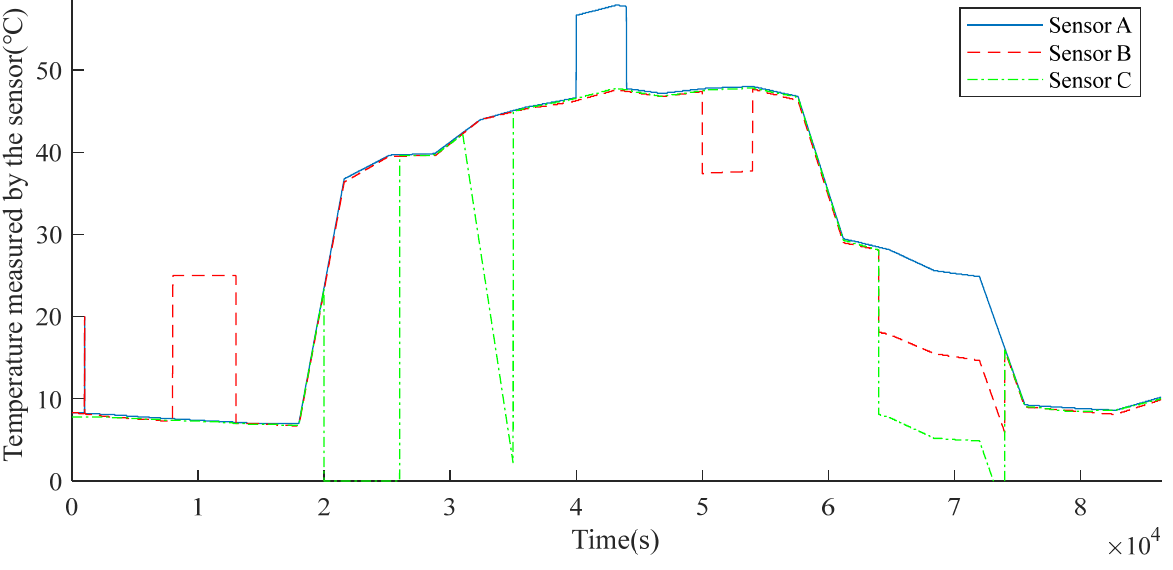
Figure 5. Simulation of the all-day fault temperature. Appl. Sci. 2022 , 12 , x FOR PEER REVIEW